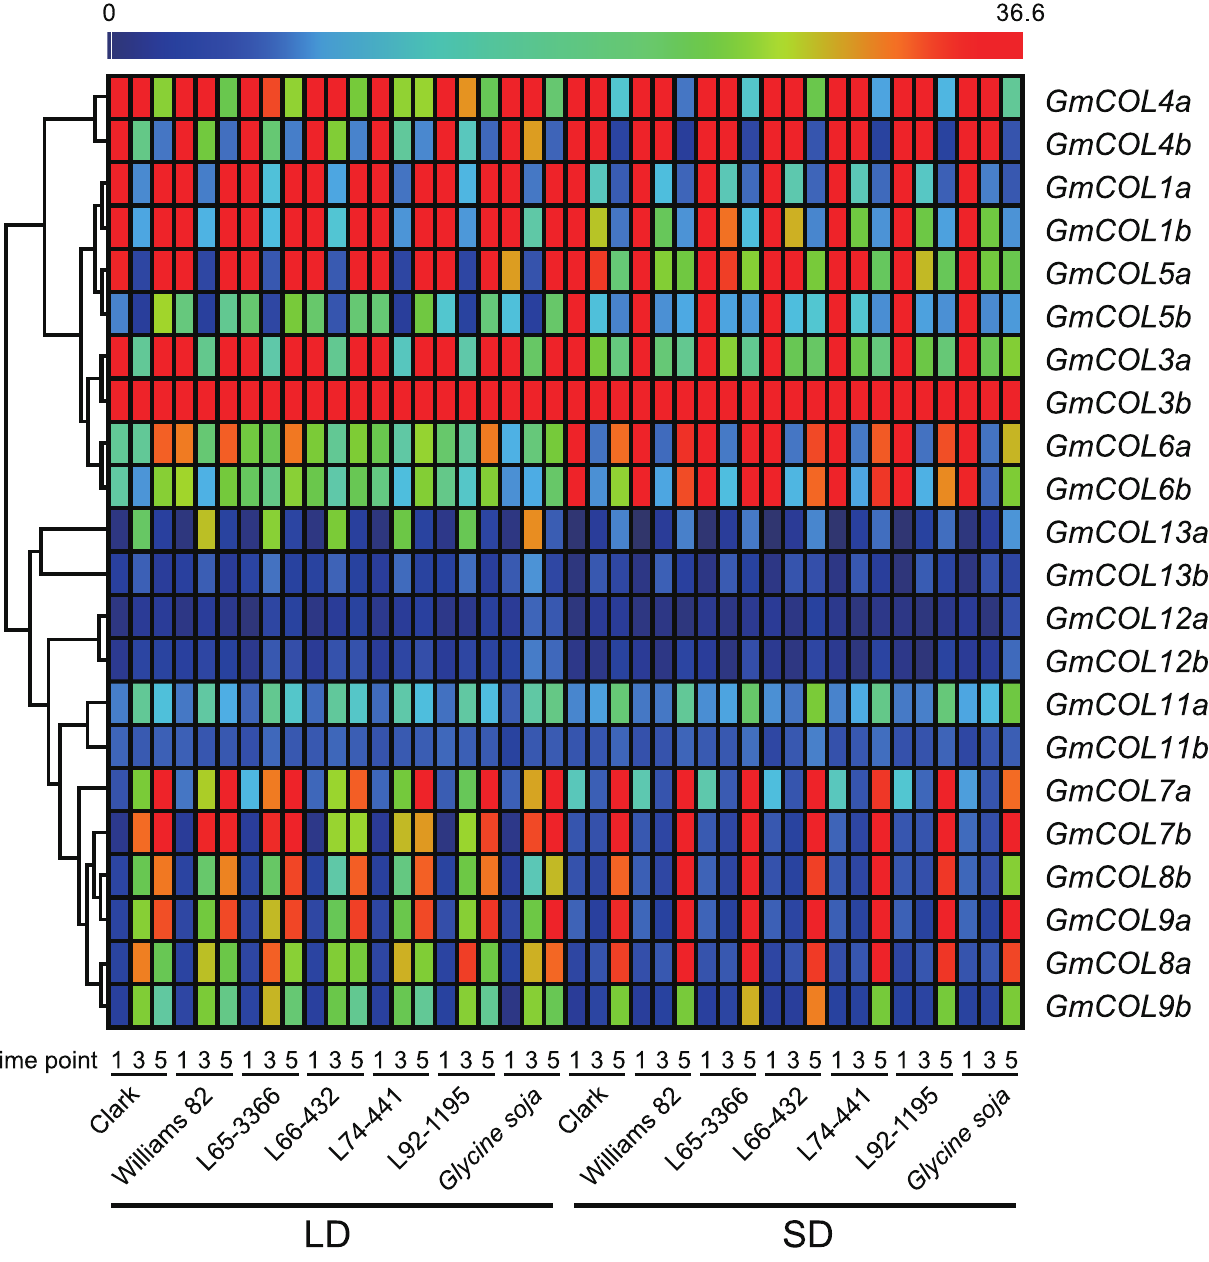
Figure 3. Hierarchical clustering of GmCOL s based on their mRNA abundance under LD and SD. GmCOL2a , GmCOL2b , GmCOL10a and GmCOL10b are excluded due to their extreme low abundance. To demonstrate the variation in the mRNA abundance, a rainbow color scheme was used in which red indicates high expression and blue indicates low expression.